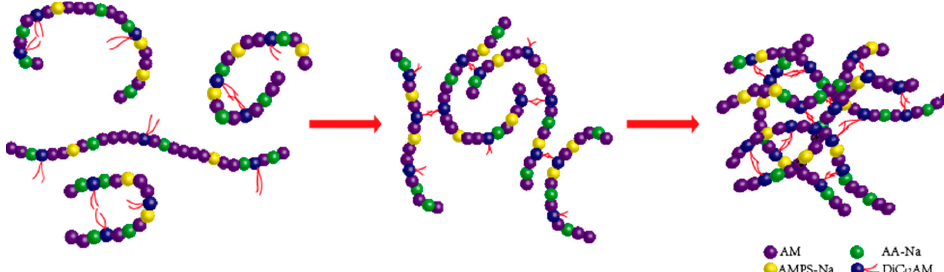
Figure 5. The association process of DiPHAM.